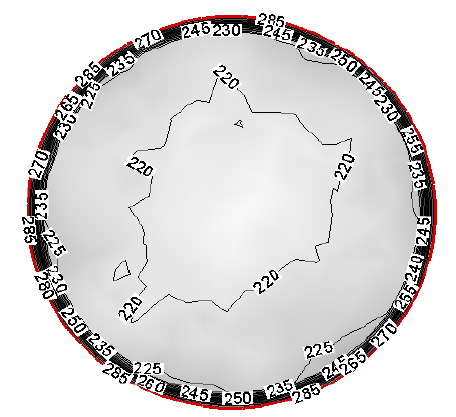
Figure 13. Contours of velocity distribution (m/s) at 0.2 cm along axial direction from the inlet nozzle in cold end at 5 bar inlet pressure.